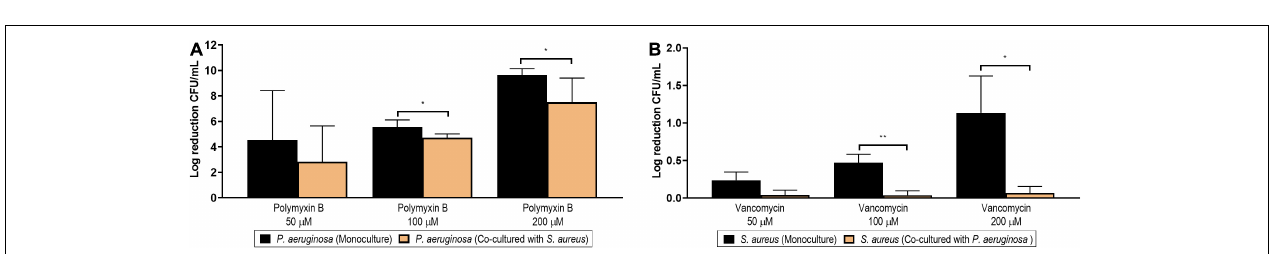
FIGURE 12 | Increase on the diameter (in mm) of a 50- µ l inoculum obtained from the combination of the biofilm and the supernatant of a Pseudomonas aeruginosa PAO1 biofilm formed in monoculture or in co-culture with Staphylococcus aureus ATCC 25923 after 8 h of incubation in soft agar. In the representative images on the right, the blue circle represents the initial diameter and the red circle the grown diameter. The results are expressed as the mean of five biological repetitions with their SD (Student’s t -test, ***p < 0.001).